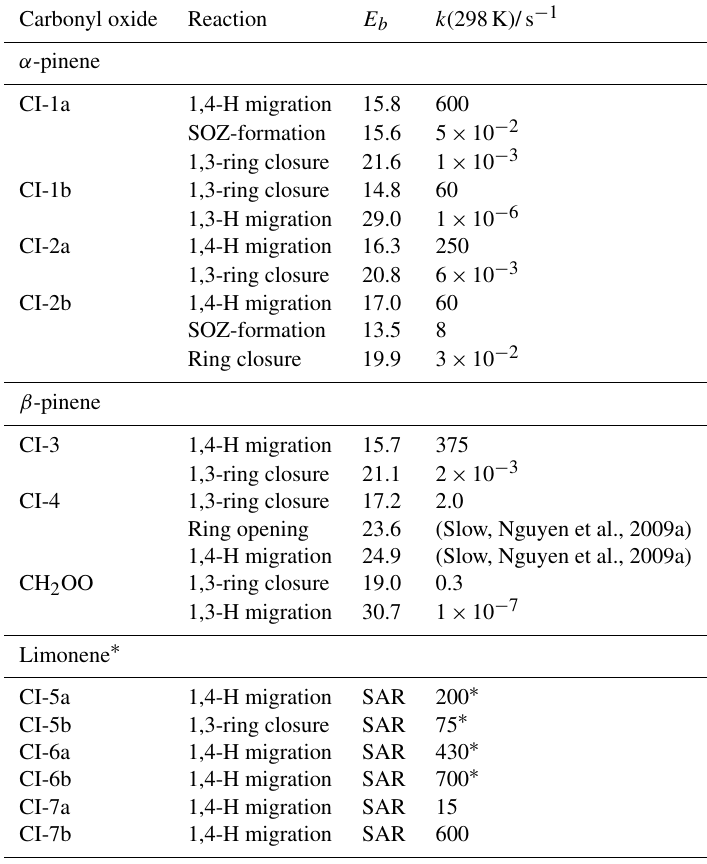
Table 3. Unimolecular reactions for the CIs derived from α -pinene, β -pinene and d -limonene, as derived by Vereecken et al. (2017). Barrier heights (kcal mol − 1 ) listed estimated post-CCSD(T)